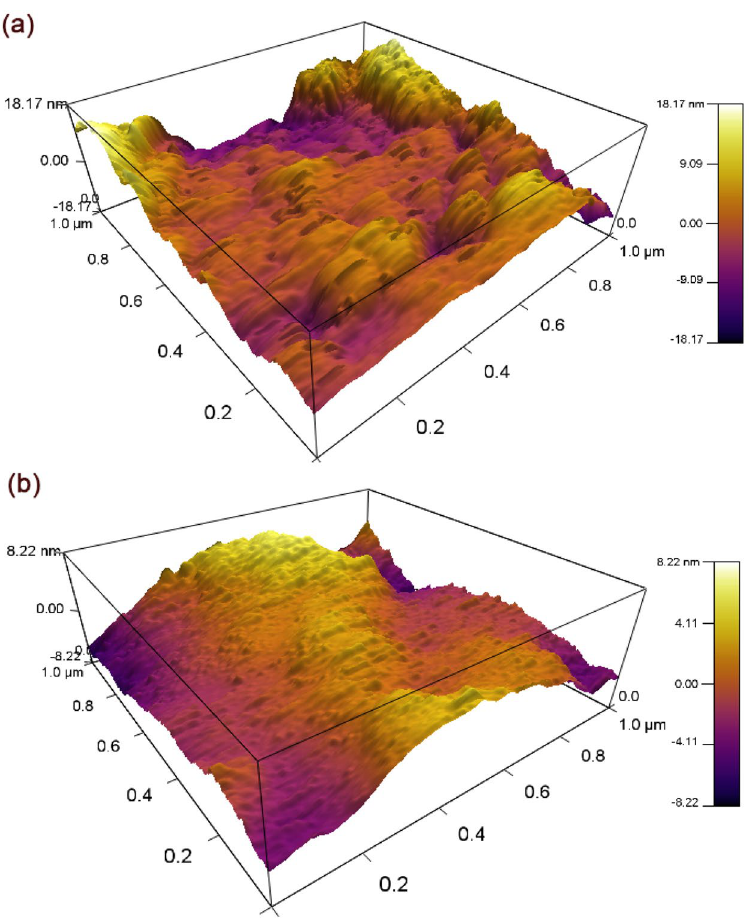
Figure 4. AFM images of 350 °C-annealed ( a ) ZnSb and ( b ) (ZnSb) 96 (NiO) 4 as a three-dimensional images with the same